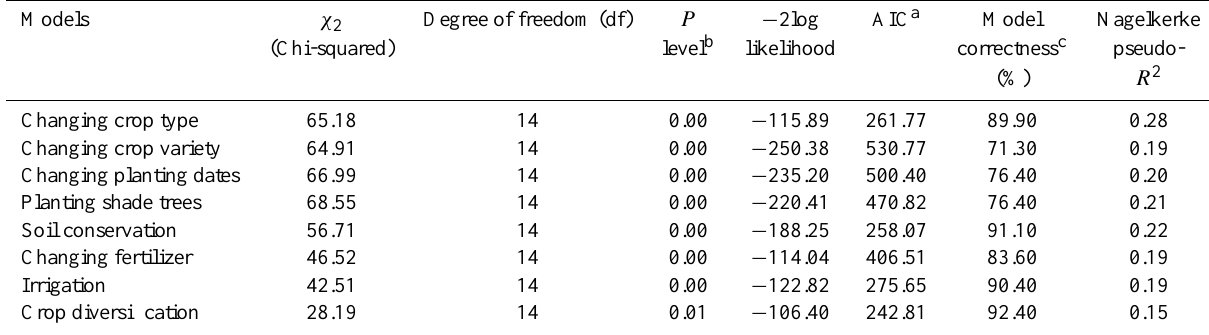
Table 3. Hypothesis testing for model significance and predictive power.